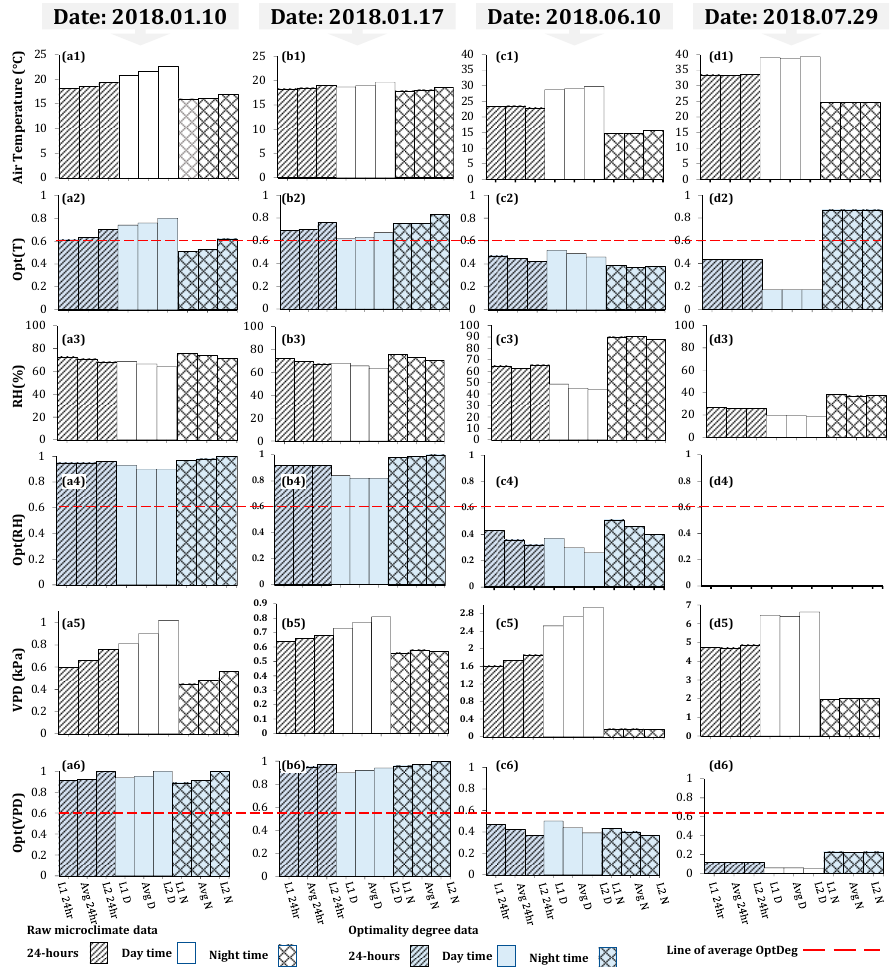
Figure 7. Average values optimality degrees of temperature, relative humidity and VPD. ( a1 ) air temperature; ( a2 ) OptDeg(T); ( a3 ) relative humidity; ( a4 ) OptDeg(RH); ( a5 ) vapor pressure deficit and ( a6 ) OptDeg(VPD) at 10 January 2018. ( b1 ) air temperature; ( b2 ) OptDeg(T); ( b3 ) relative humidity; ( b4 ) OptDeg(RH); ( b5 ) vapor pressure deficit and ( b6 ) OptDeg(VPD) at 17 January 2018. ( c1 ) air temperature; ( c2 ) OptDeg(T); ( c3 ) relative humidity; ( c4 ) OptDeg(RH); ( c5 ) vapor pressure deficit and ( c6 ) OptDeg(VPD) at 10 June 2018. ( d1 ) air temperature; ( d2 ) OptDeg(T); ( d3 ) relative humidity; ( d4 ) OptDeg(RH); ( d5 ) vapor pressure deficit and ( d6 ) OptDeg(VPD) at 29 July 2018. . L1 and L2 are 1.4 and 2.2 m above the ground in 10 January 2018, 17 January 2018 and 10 June 2018; L1 and L2 are 0.6 and 2.2 m height in 29 July 2018; D, N and 24 hr are day, night, day and night, respectively; Avg denote average. The dashed line is OptDeg average in total